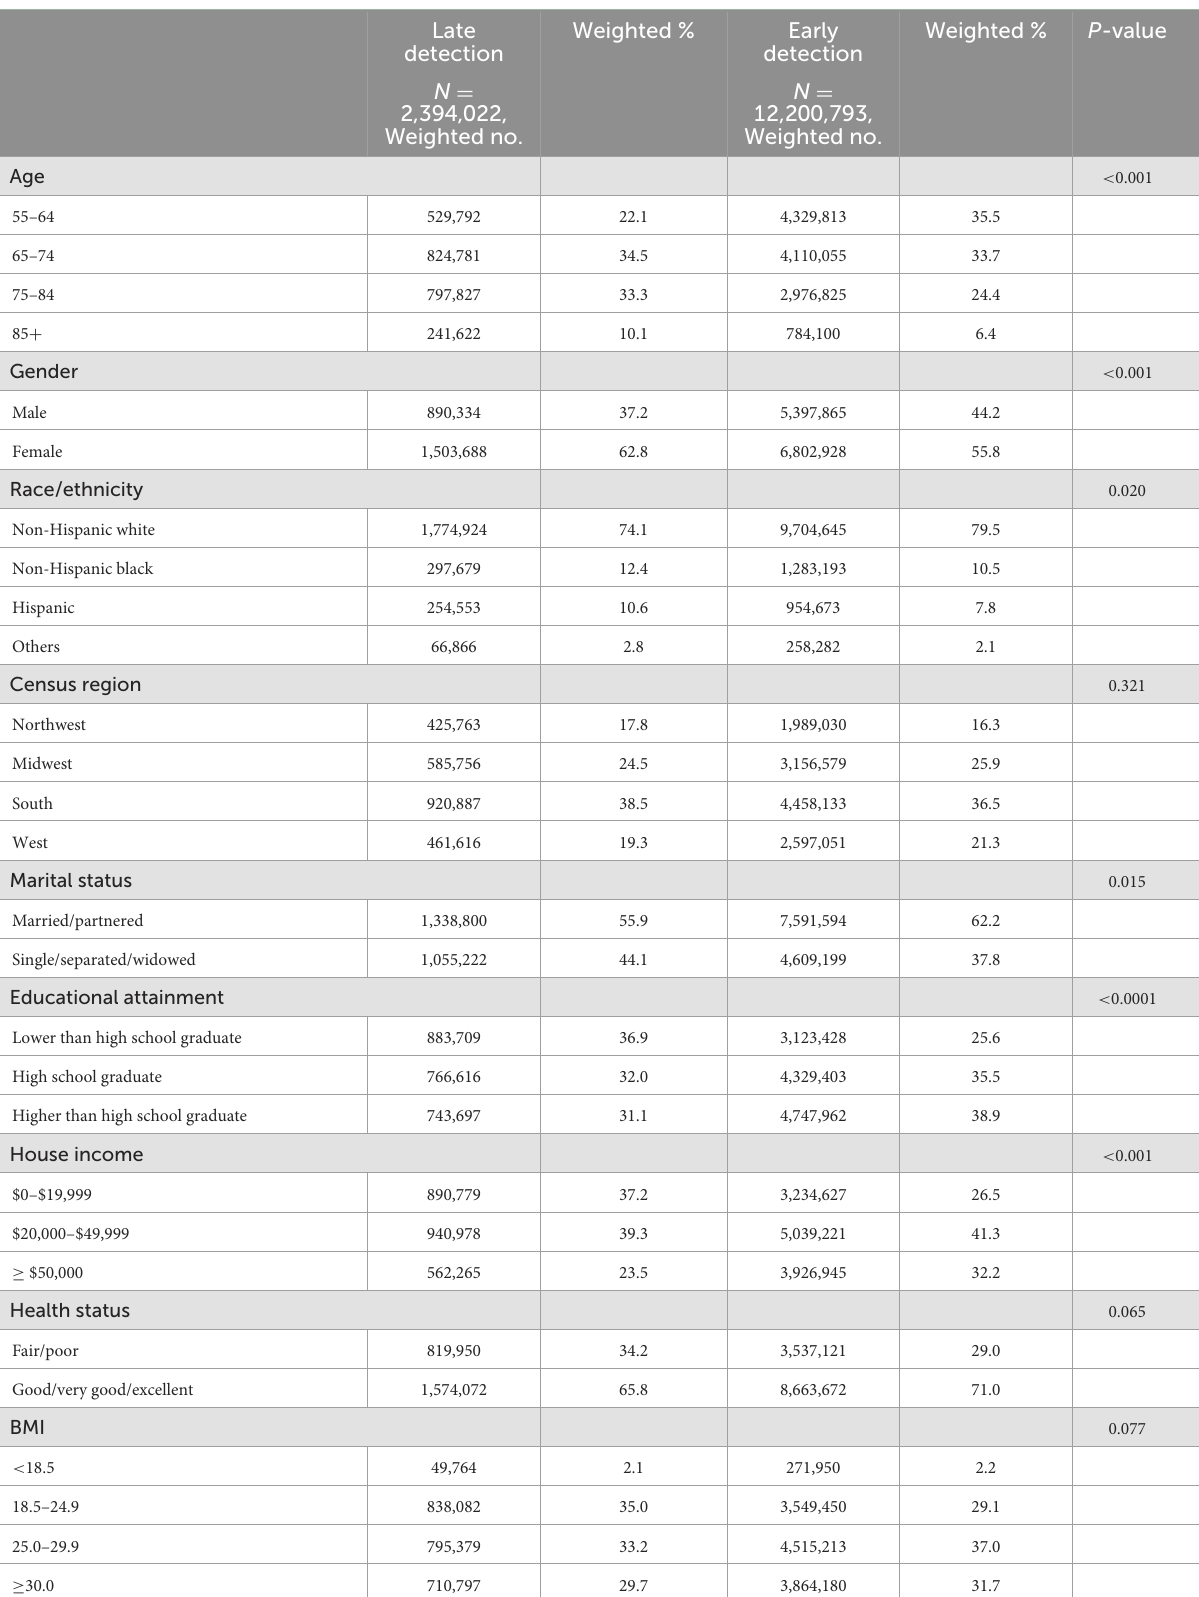
TABLE 1 Descriptive characteristics of baseline study sample between late and early detection of